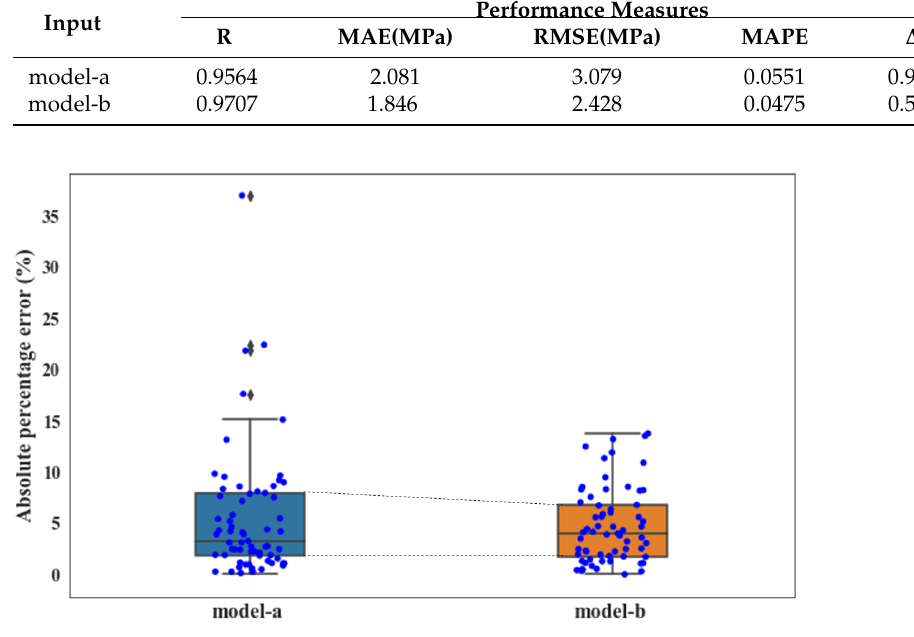
Figure 6. Boxplot of error on testing set obtained by model-a and